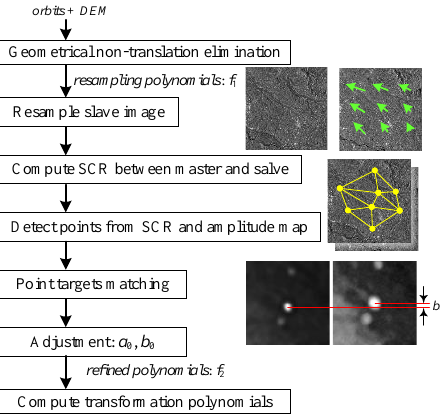
Figure 2. Improved high-accuracy interferometric synthetic-aperture radar co-registration method used in this study. DEM: digital elevation model; SCR: signal-to-clutter-ratio.